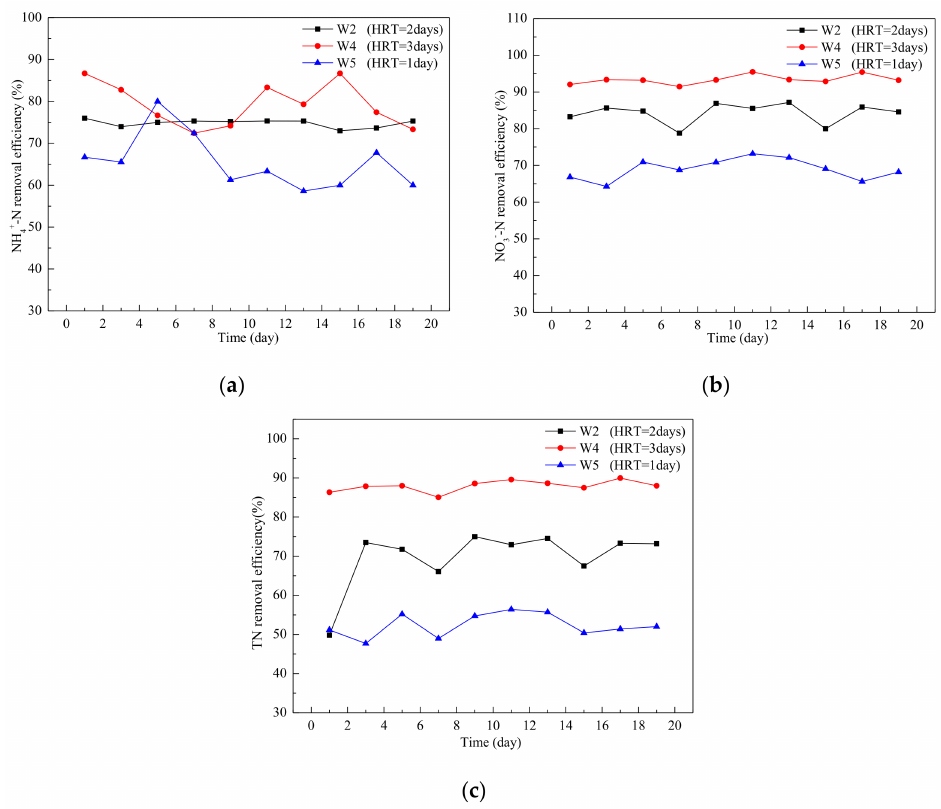
Figure 6. Effect of HRT on NH 4+ -N, NO 3 − -N, TN removal; ( a ) NH 4+ -N; ( b ) NO 3 − -N; and ( c )